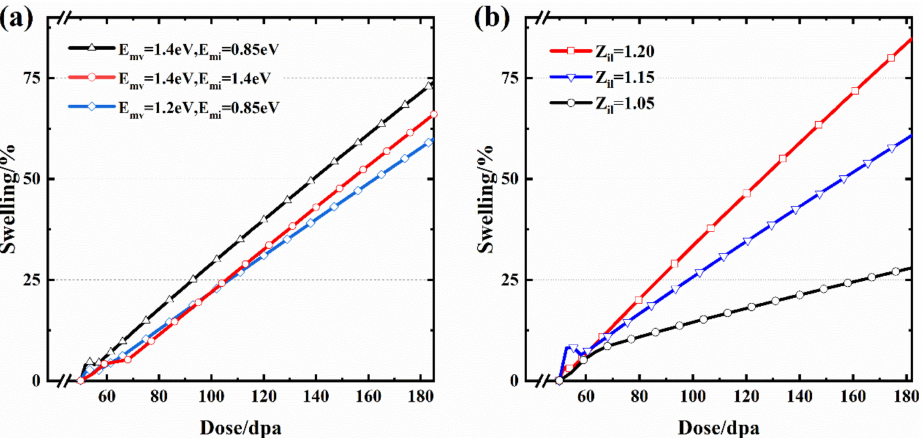
Figure 8. ( a ) The swelling of AISI 316 with different E mv or E mi . The black line with triangles: E mv = 1.4 eV and E mi = 0.85 eV; the red line with circles: E mv = 1.4 eV and E mi = 1.4 eV; the blue line with squares: E mv = 1.2 eV and E mi = 0.85 eV. ( b ) The swelling plots as a function of doses at 450 ◦ C with the loop biases Z il equal to 1.05, 1.15, and 1.20,